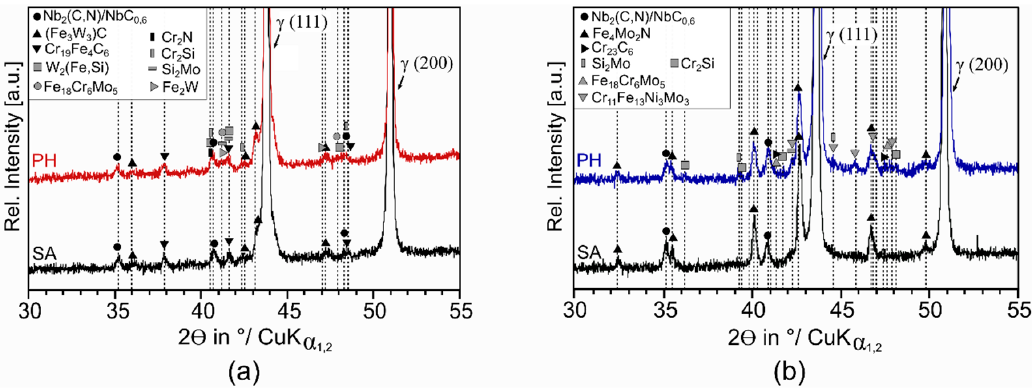
Figure 5. XRD pattern of the steel 1.4957 ( a ) and 5Mo-2W ( b ) in the solution-annealed (SA) and aged condition (PH) measured via XRD.